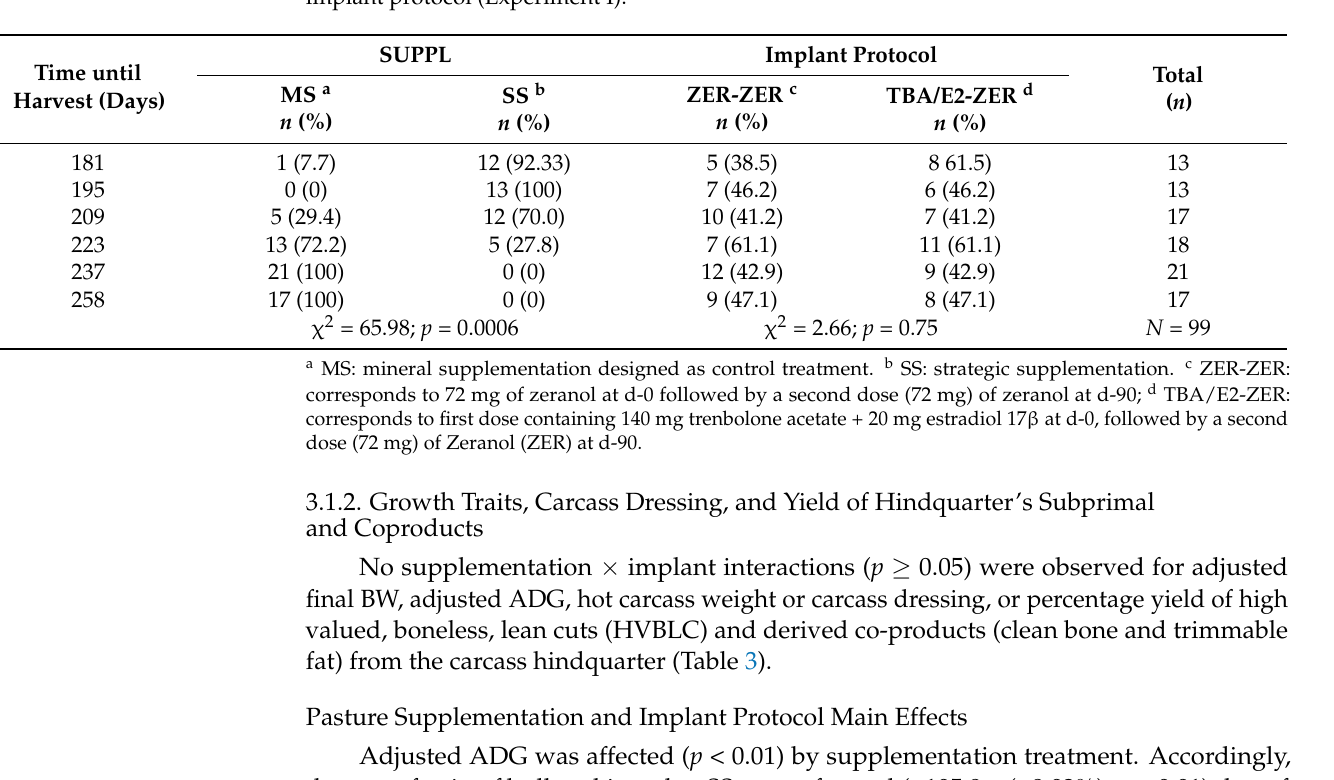
Table 2. Frequency distribution by fattening days according to supplementation treatment and implant protocol (Experiment